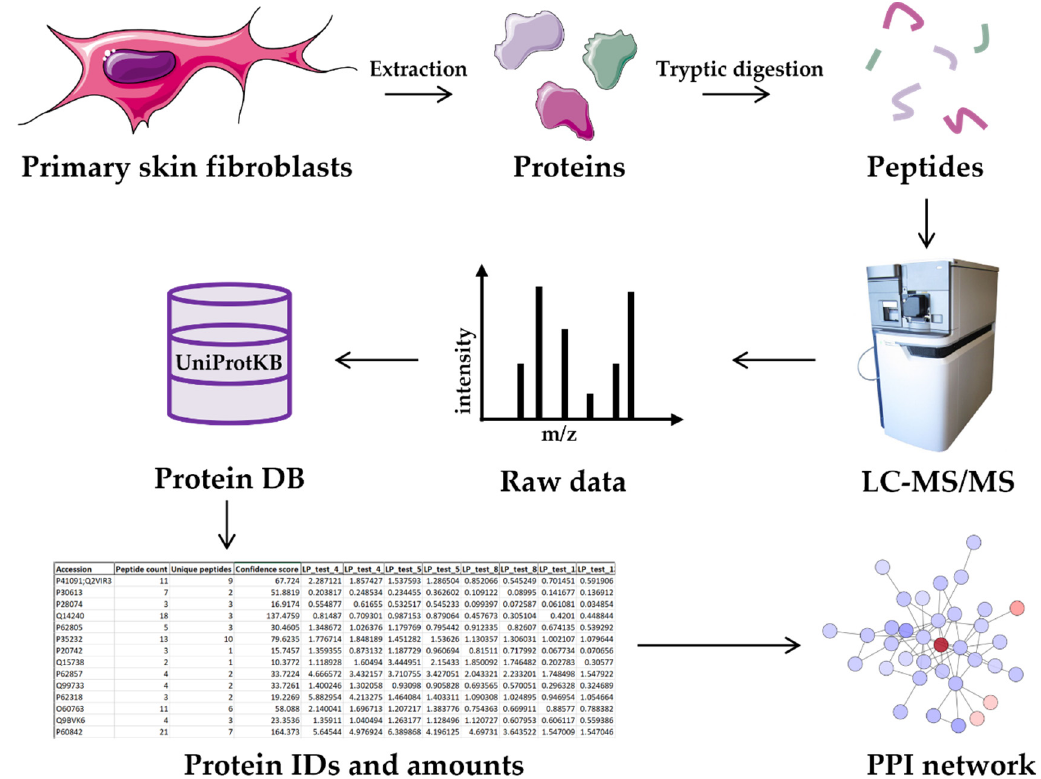
Figure 1. Experimental workflow. Proteins extracted from primary skin fibroblasts of all patients were digested with trypsin and the peptides were analyzed by LC-MS/MS. The resulting raw data were used to query the UniProt database and proteins were identified. The list of identified and quantified proteins was used for subsequent analyses, including differential expression analysis, PPI networks generation and functional enrichment analysis (cell and proteins images from: https://bioicons.com/ (accessed on 9 July 2021)).